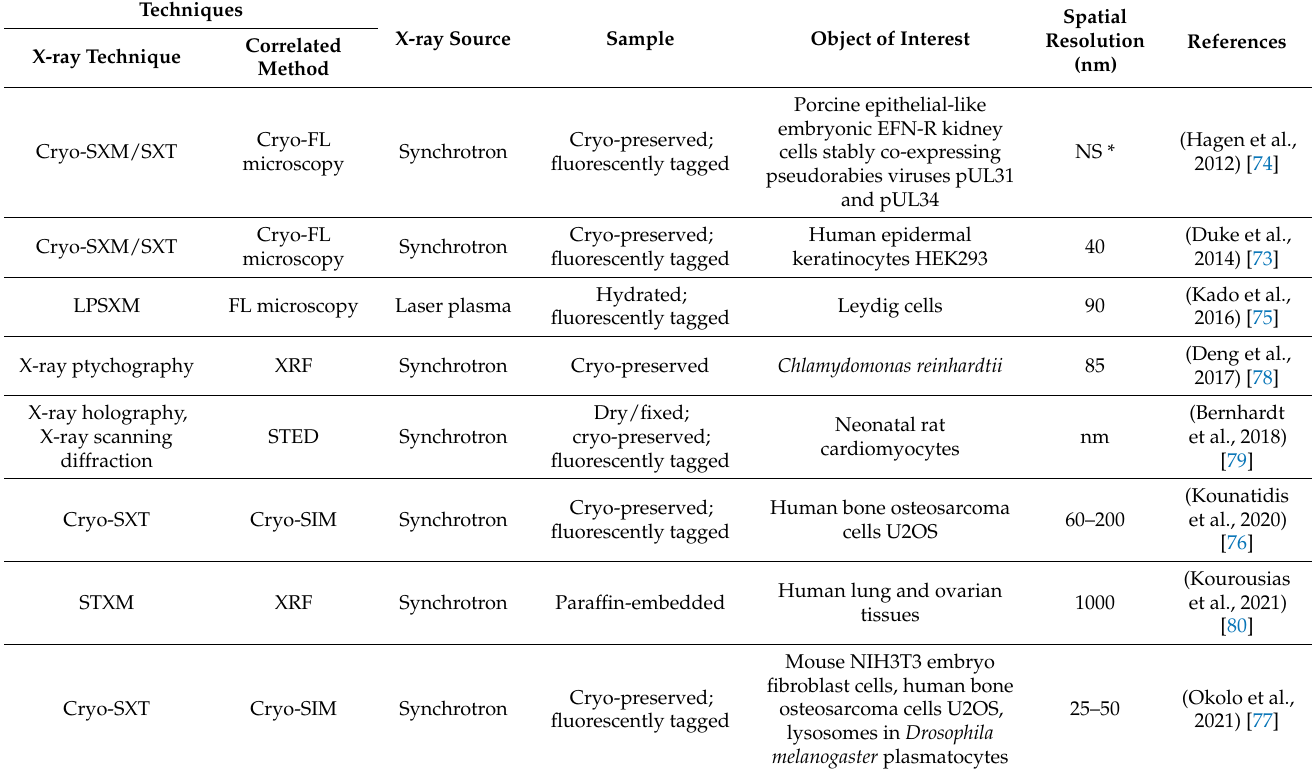
Table 2. Selected current biological and medical applications of X-ray-related correlative